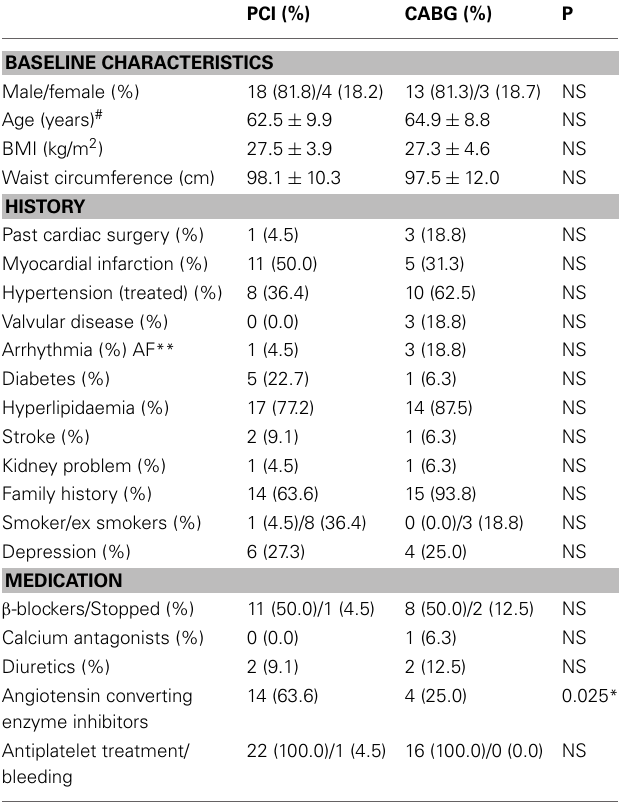
Table 1 | Patient demographics and clinical